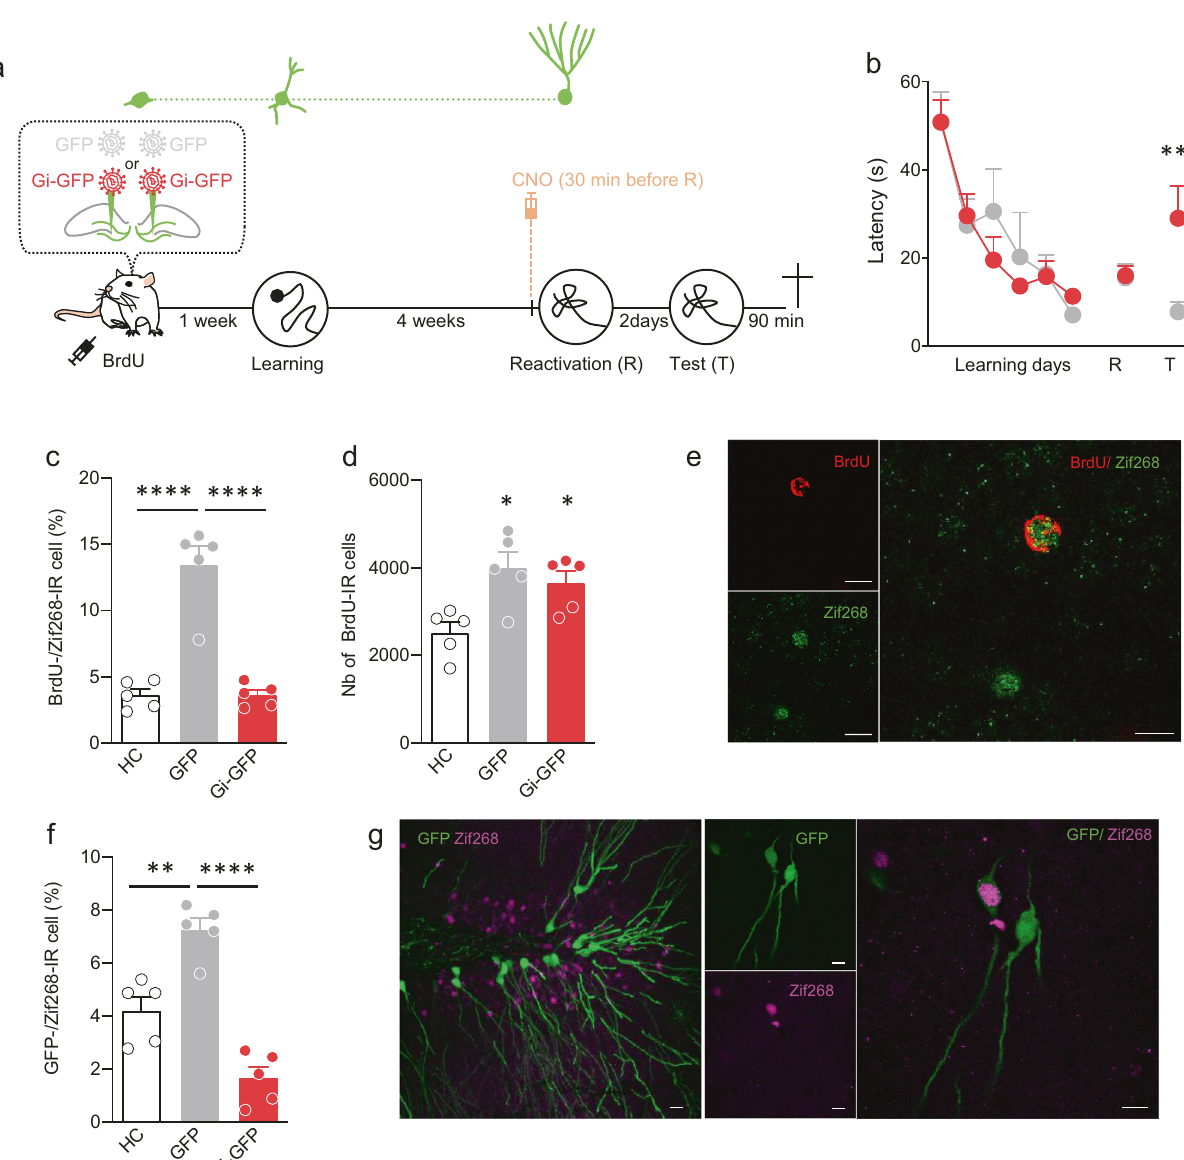
Fig. 4 Silencing during reconsolidation, neurons that were immature at the time of learning, impairs long-term memory persistence. a Experimental protocol: 2-month-old rats were injected with Gi-GFP RV ( n = 5) or its control GFP RV ( n = 6) 1 week before MWM training. Rats were trained for 6 days and memory was reactivated 4 weeks later. Thirty minutes before reactivation, CNO (1 mg/kg) was injected (i.p.). Memory was tested 2 days later (Test) and all animals were killed 90 min after the test. b Latency to fi nd the platform during training and to fi rst cross the position of the platform during the reactivation and test trial. Memory performances of Gi-GFP rats were impaired at Test compared to those of GFP RV rats (Tukey ’ s test: ** p < 0.01). c Zif268 expression in BrdU-IR cells. Percentage of expression was higher in the GFP rats compared to that of control home cage (HC, n = 5) rats and to that of Gi-FGP rats (Tukey ’ s test: **** p < 0.0001). d Number of BrdU-IR cells. The number of BrdU-IR cells was similar between the GFP and Gi-GFP groups and for both higher compared to that of home cage (HC, n = 5) animals (Tukey ’ s test: * p < 0.05). e Confocal illustration showing BrdU-IR cells (red) coexpressing the cellular activation factor Zif268-IR (green). Bar scale 10 µ m. f Zif268 expression in GFP-IR cells. Percentage of expression was higher in the GFP rats compared to that of control HC rats ( n = 5) and to that of Gi-FGP rats (Tukey ’ s test: ** p < 0.01, **** p < 0.0001). g Confocal illustration showing GFP-IR cells (green) coexpressing the cellular activation factor Zif268-IR (magenta). Bar scale 10 µ m. All data shown are mean ± s.e.m. For statistical details, see Table